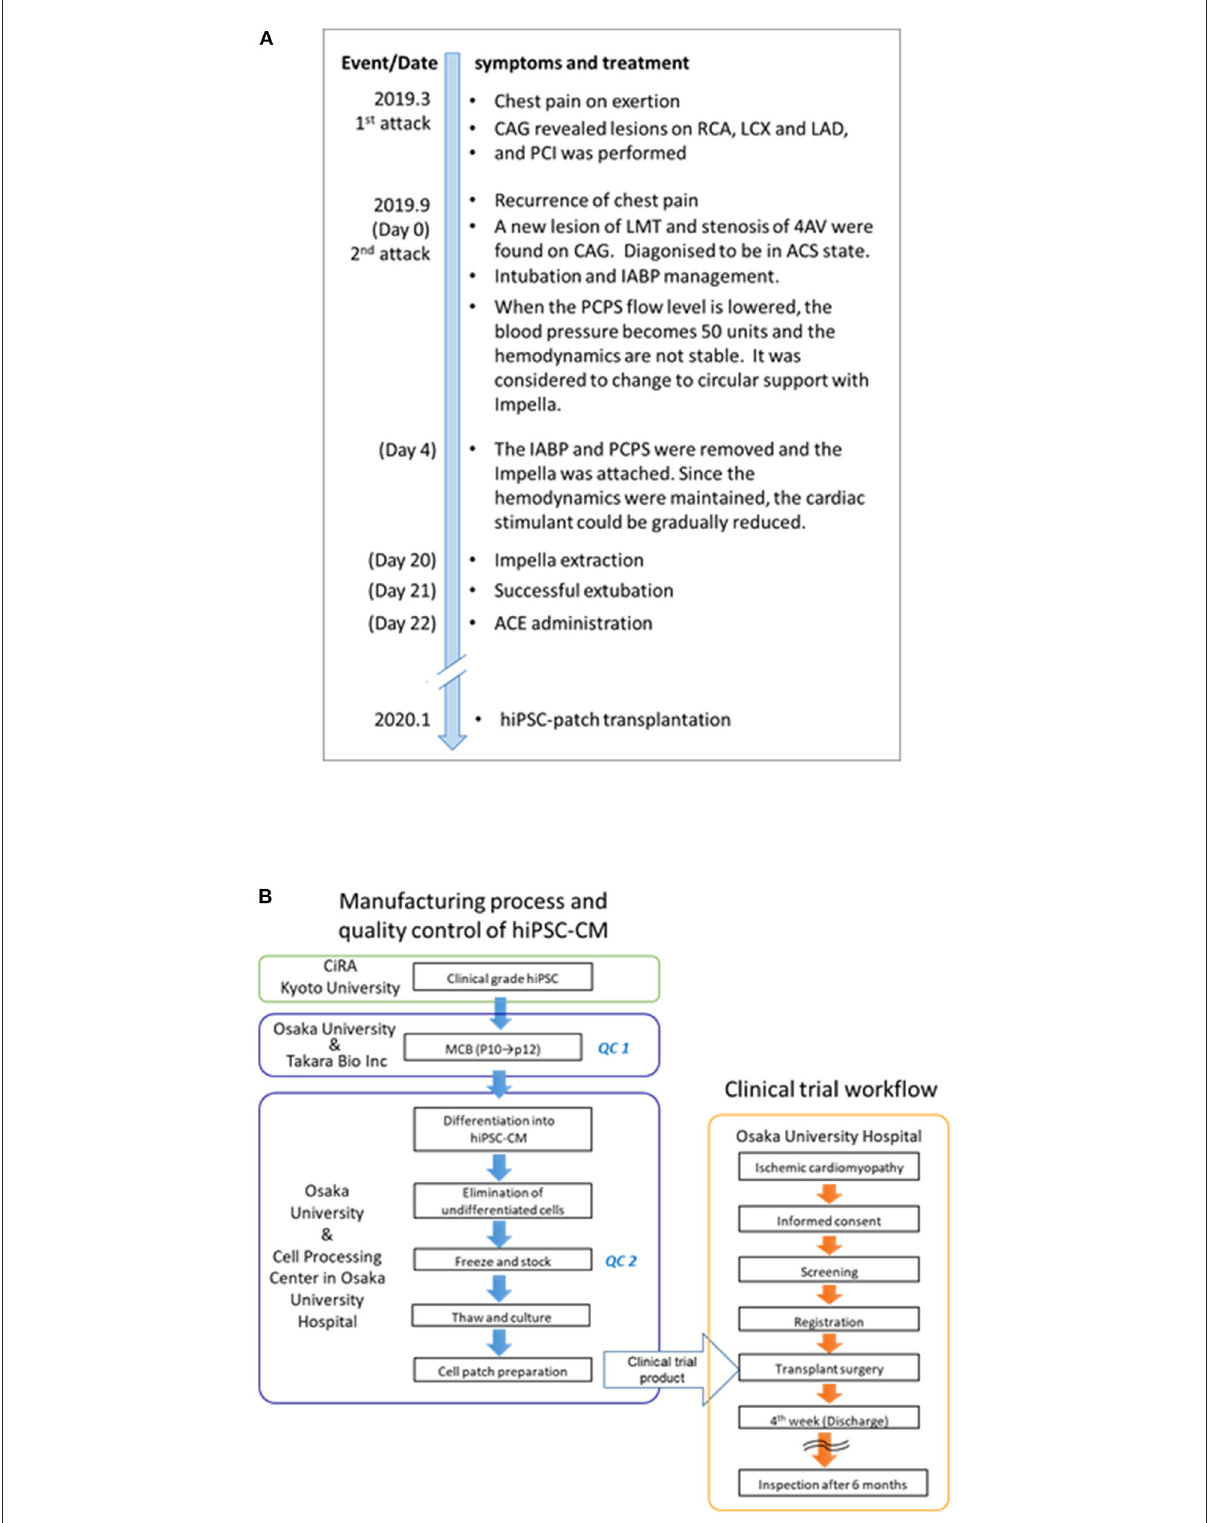
FIGURE1 Timeline of symptoms and treatment and the clinical trial flowchart of the human induced pluripotent stem (iPS) cell-derived cardiomyocyte (hiPSC-CM) patches. (A) The date in parentheses indicates the number of days since the first attack. The patient underwent anti-heart failure medications (maximum dosages), such as beta-blockers, ACE inhibitors, and diuretics, before transplantation. In the first 3 months after